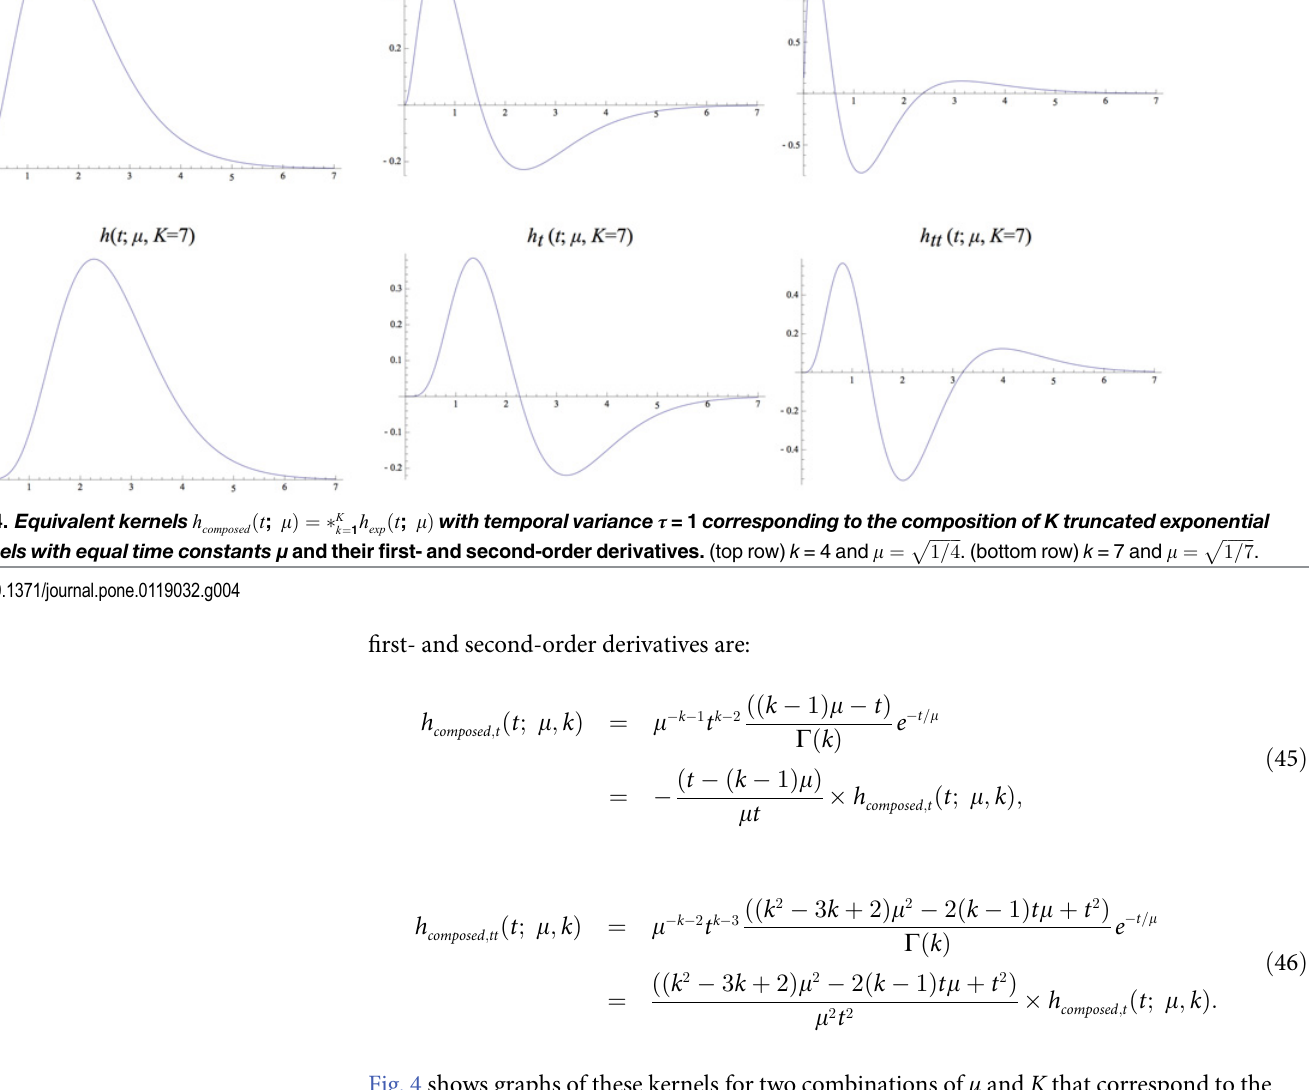
ð t ; m Þ ¼ (cid:3) K ð t ; m Þ with temporal variance τ = 1 corresponding to the composition of K truncated exponential h composed exp k ¼ 1